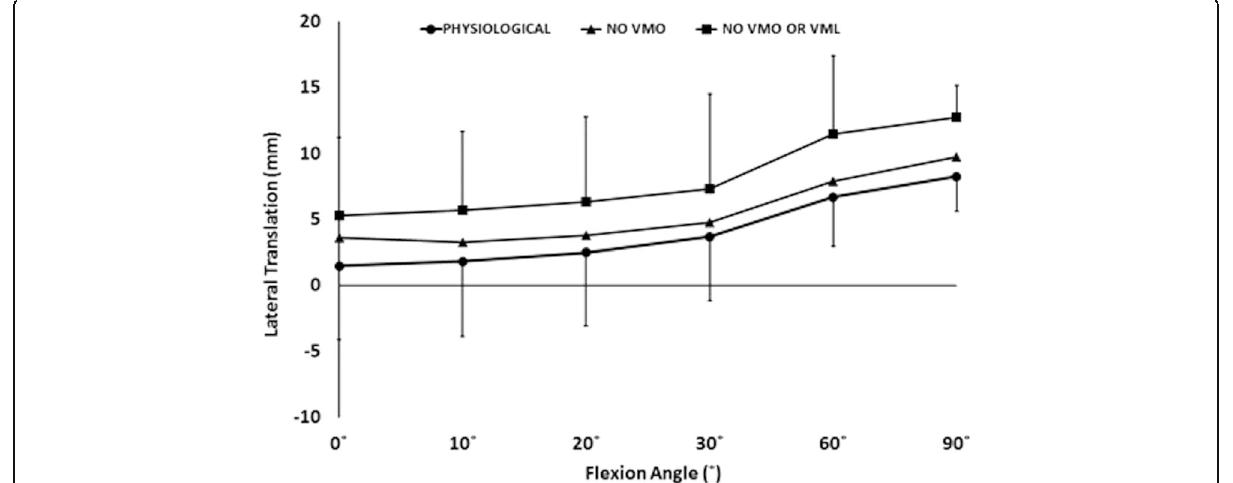
Fig. 2 Patellar lateral translation (mm) across knee flexion (mean +/- SD;